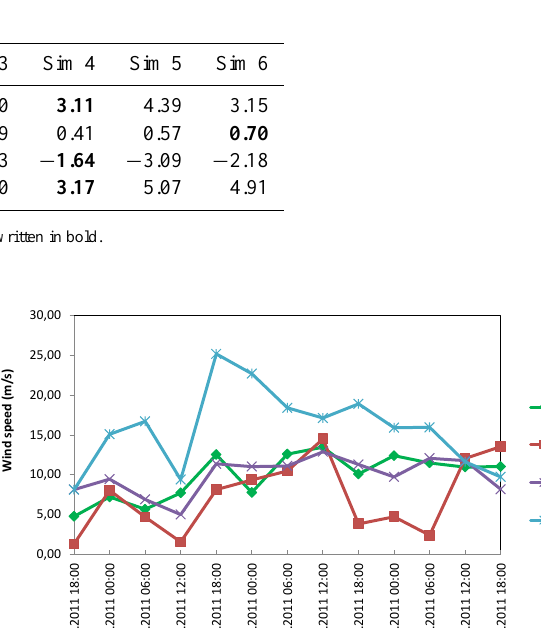
Table 6. Statistical evaluation of different simulations for wind speed.